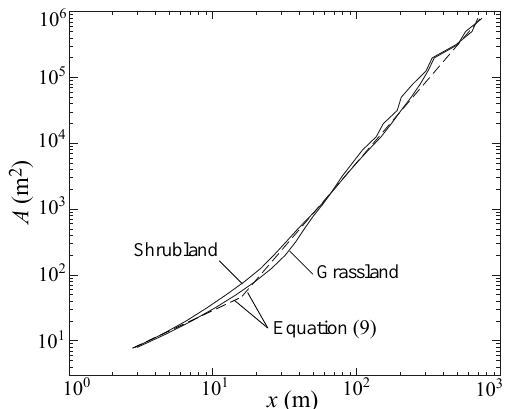
Figure 7. Plots of contributing area vs. mean distance from the di- vide for the shrubland (approximated as the portion of the study area below 1430ma.s.l.) and grassland areas (above 1430m). The dashed line plots the piecewise power-law relationship (Eq. 9) ex- hibited by the